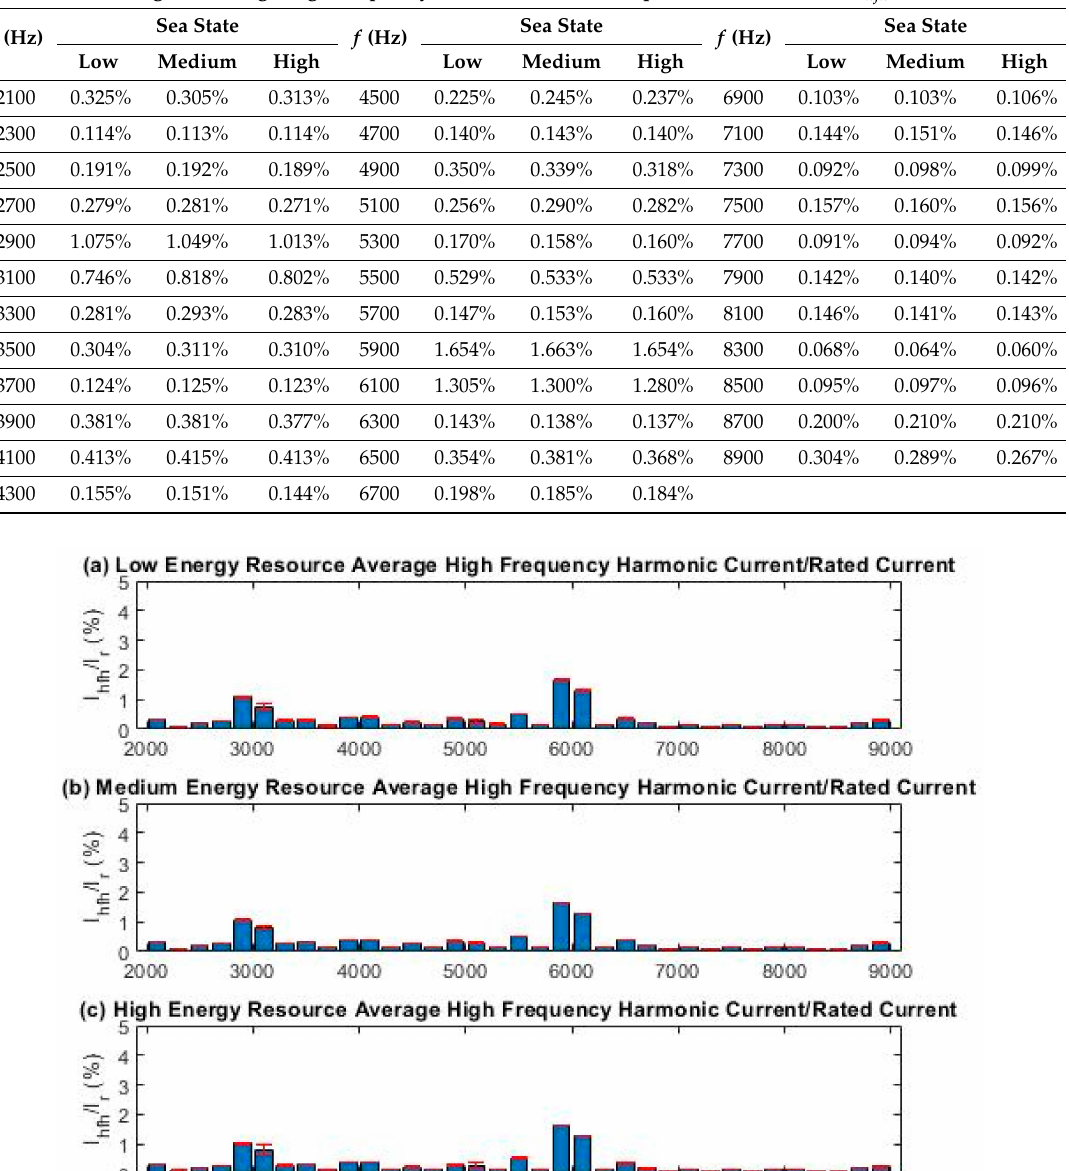
Table 7. Laboratory trial average reportable ratios of high-frequency harmonic current amplitudes for each resource classification.